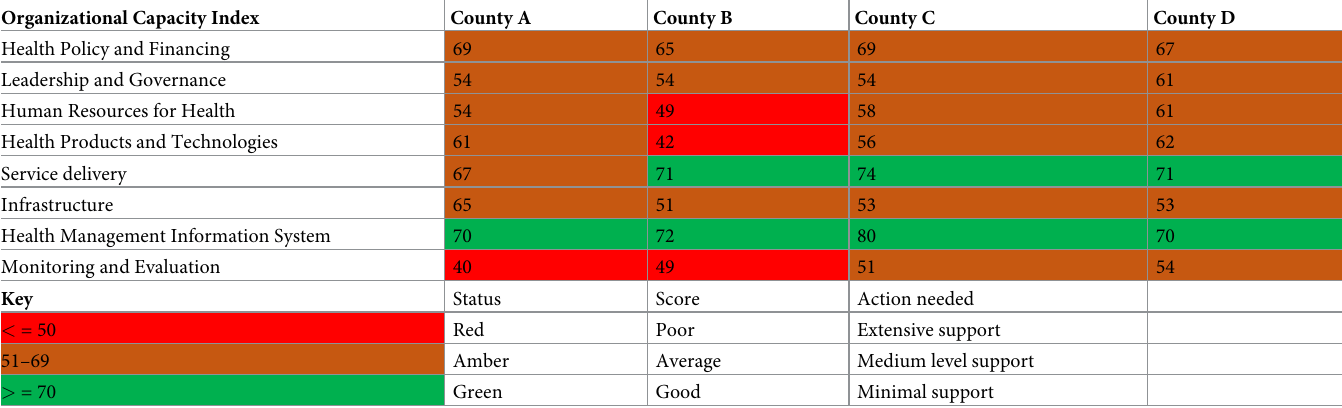
Table 2. Scores by health systems